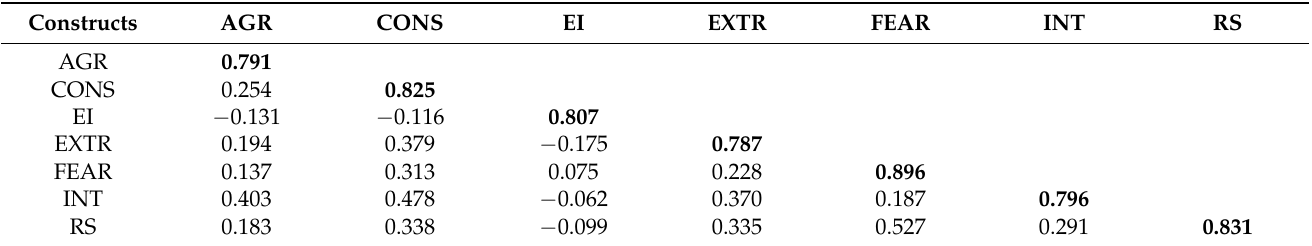
Table 4. Assessment of discriminant validity (Fornell-Larker